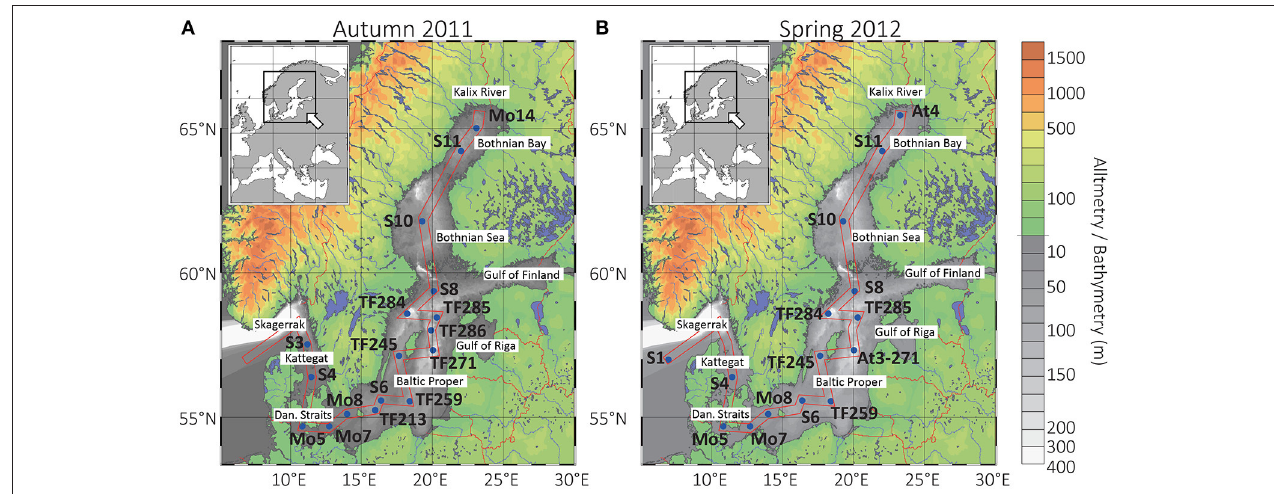
FIGURE 1 | Map of the Baltic Sea with sampling stations. Sampling transects in autumn 2011 (A) and in spring 2012 (B) . The Gotland and Landsort Deeps are located at stations TF271 (autumn), At3-271 (spring), and TF284 (autumn and spring), respectively. Dan. Straits, Danish